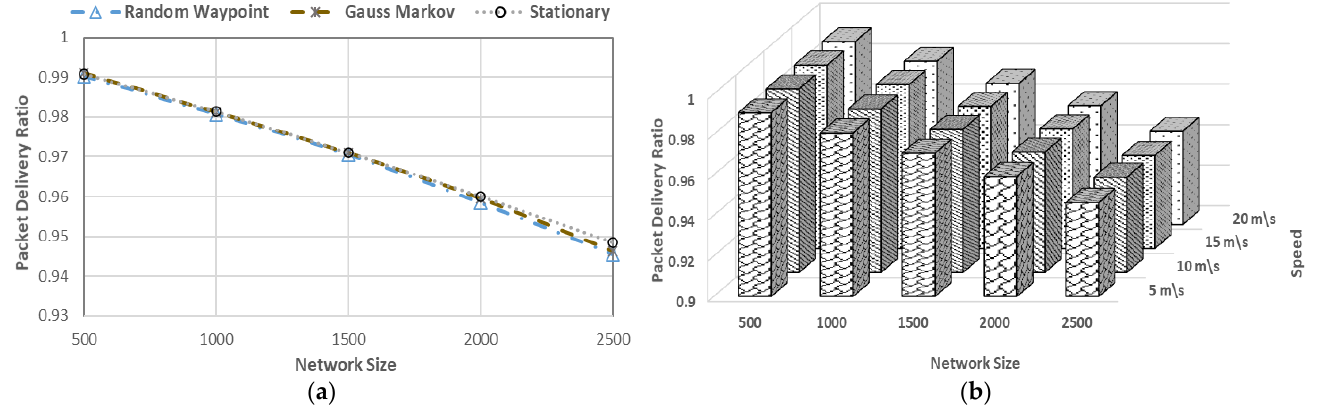
Figure 4. Packet delivery ratio: ( a ) packet delivery ratio for a network with 1000 × 1000 area, 100 B payload, and 25 m/s speed; ( b ) packet delivery ratio for a network with 1000 × 1000 area using the random waypoint mobility model.